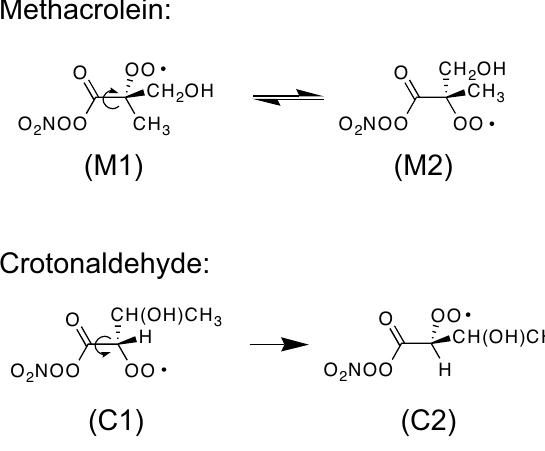
Fig. 14. Rotational conformers of hypothesized SOA intermediate in methacrolein and crotonaldehyde mechanism. For methacrolein, the methyl group on the α -carbon presents significant steric hin- derance, which favors the conformer M2. This increases the in- teraction between the peroxy radical and the peroxy nitrate group, leading to significant SOA formation. For crotonaldehyde, the hy- drogen atom presents much smaller steric hinderance, favoring the conformer C2. As a result, the peroxy radical is out of plane with the PAN group, and the reaction to form SOA can be less